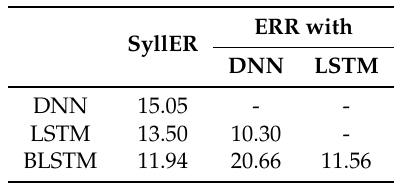
Table 5. Comparison of SyllER (%) of the Korean online ASR systems employing deep neural network (DNN), LSTM, and BLSTM AMs for the test set. Our baseline ASR system uses the BLSTM AM.